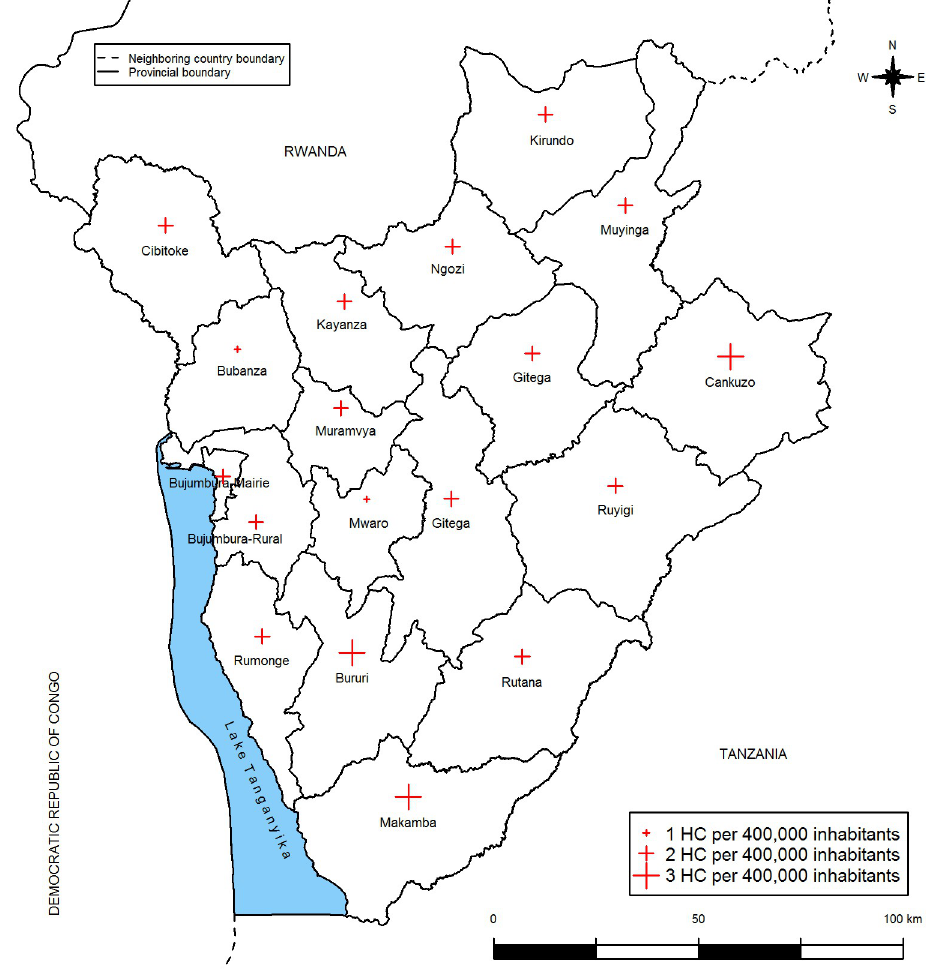
Fig 4. Spatial distribution of health centers in